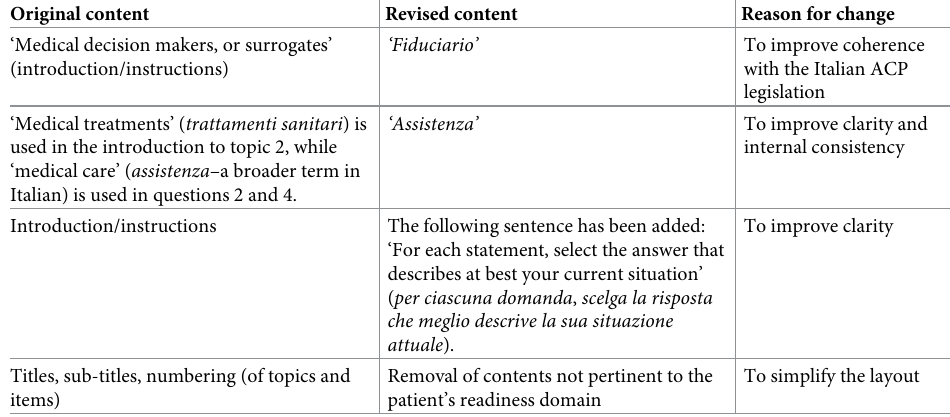
Table 2. Overview of revisions made to the 4-item ACP engagement questionnaire. Original content Revised content Reason for change ‘Medical decision makers, or surrogates’ ‘Fiduciario’ To improve coherence (introduction/instructions) with the Italian ACP legislation ‘Medical treatments’ ( trattamenti sanitari ) is ‘Assistenza’ To improve clarity and used in the introduction to topic 2, while internal ‘medical care’ ( assistenza –a broader term in Italian) is used in questions 2 and 4.